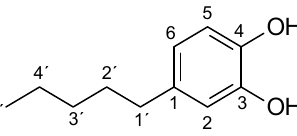
Figure A5. 4- n -pentylcatechol ( 5b ). 1 H NMR (399.87 MHz, DMSO- d 6 , 30 °C): 0.850 (3H, m, J = 7.1 Hz, H-5 ′ ), 1.24 H (2H, m, H-3 ′ ), 1.28 H (2H, m, H-4 ′ ), 1.483 (2H, m, H-2 ′ ), 2.377 (2H, m, H-1 ′ ), 6.402 (1H, dd, J = 8.0, 2.1 Hz, H-6), 6.552 (1H, d, J = 2.1 Hz, H-2), 6.613 (1H, d, J = 8.0 Hz, H-5), 8.561 (2H, br s, 3,4-OH); H HSQC readout. 13 C NMR (100.55 MHz, DMSO- d 6 , 30 °C): 13.83 (C-5 ′ ), 21.91 (C-4 ′ ), 30.79 (C-3 ′ ), 30.81 (C-2 ′ ), 34.42 (C-1 ′ ), 115.31 (C-5), 115.58 (C-2), 118.72 (C-6), 133.08 (C-1), 142.96 (C-4), 144.86 (C-3).